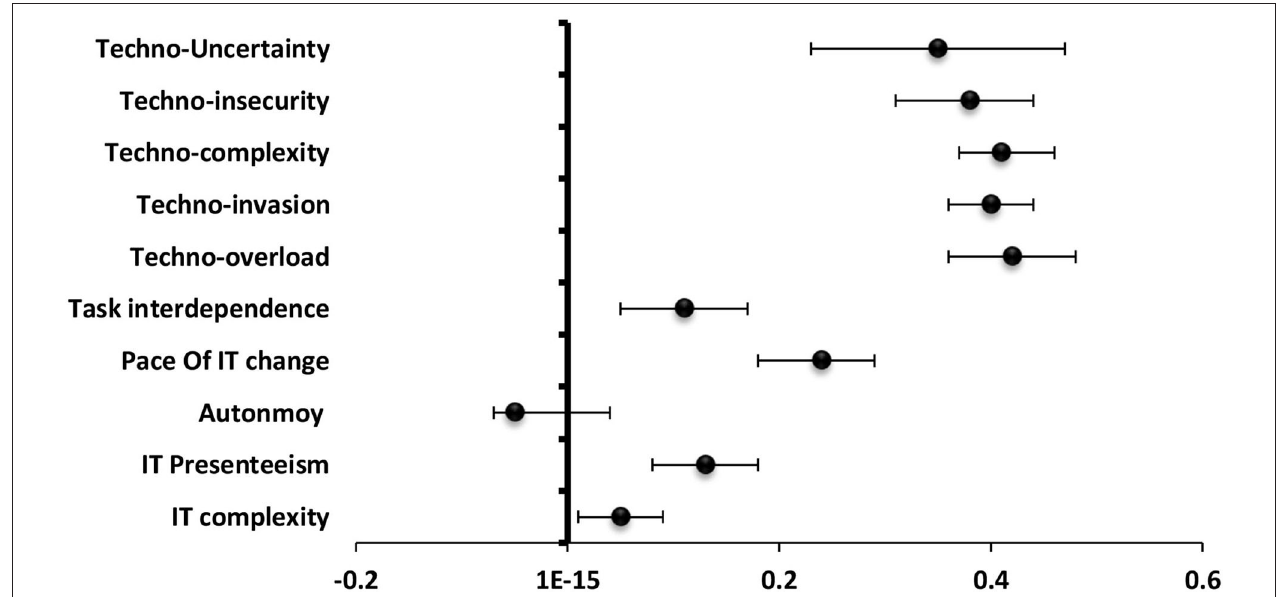
FIGURE 3 | Values of β and CI 95% for linear regression analysis of technostress items and job and technology characteristics as a predictor to burnout among staff.